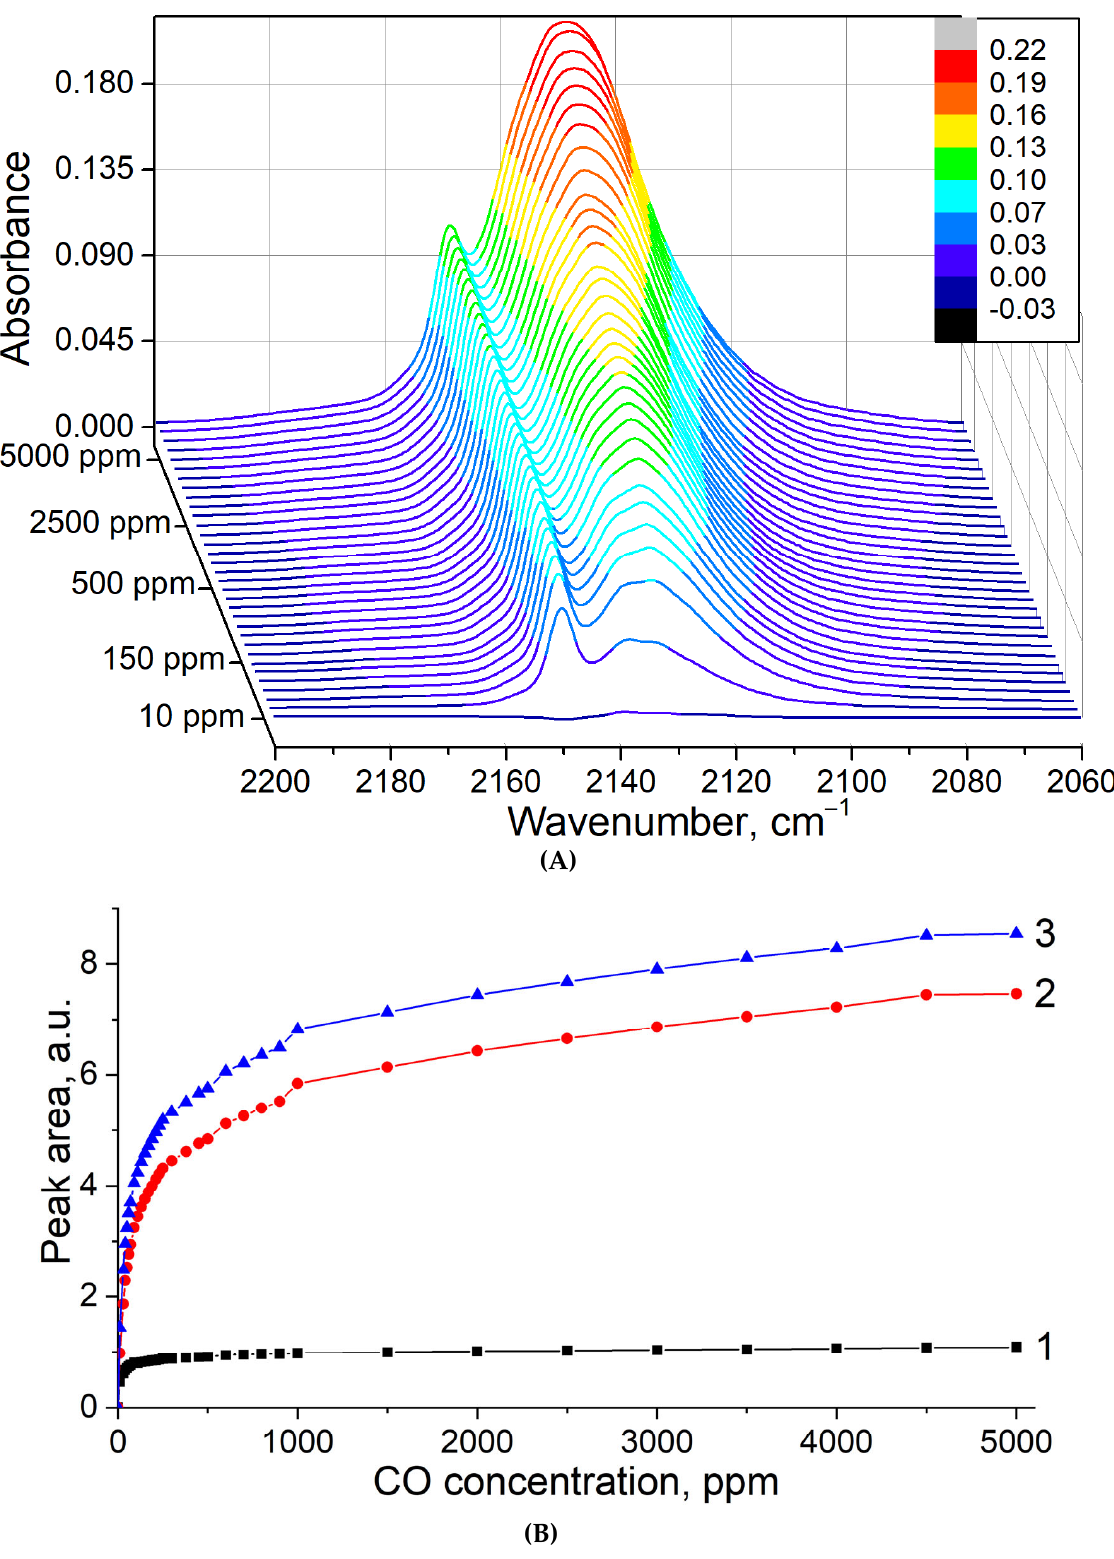
Figure 10. ( A ) Waterfall graph of difference FTIR spectra of CuSn ‐ BEA in vacuo after saturation with ~1500 ppm of H 2 O followed by CO adsorption; 10 to 5000 ppm. ( B ) Evolution of the total peak area of CO adsorbed on CuSn ‐ BEA in the humid environment (1500 ppm of H 2 O); 10–5000 ppm; 2149 cm − 1 peak (1), 2132 cm − 1 peak (2) and total peak area (3).